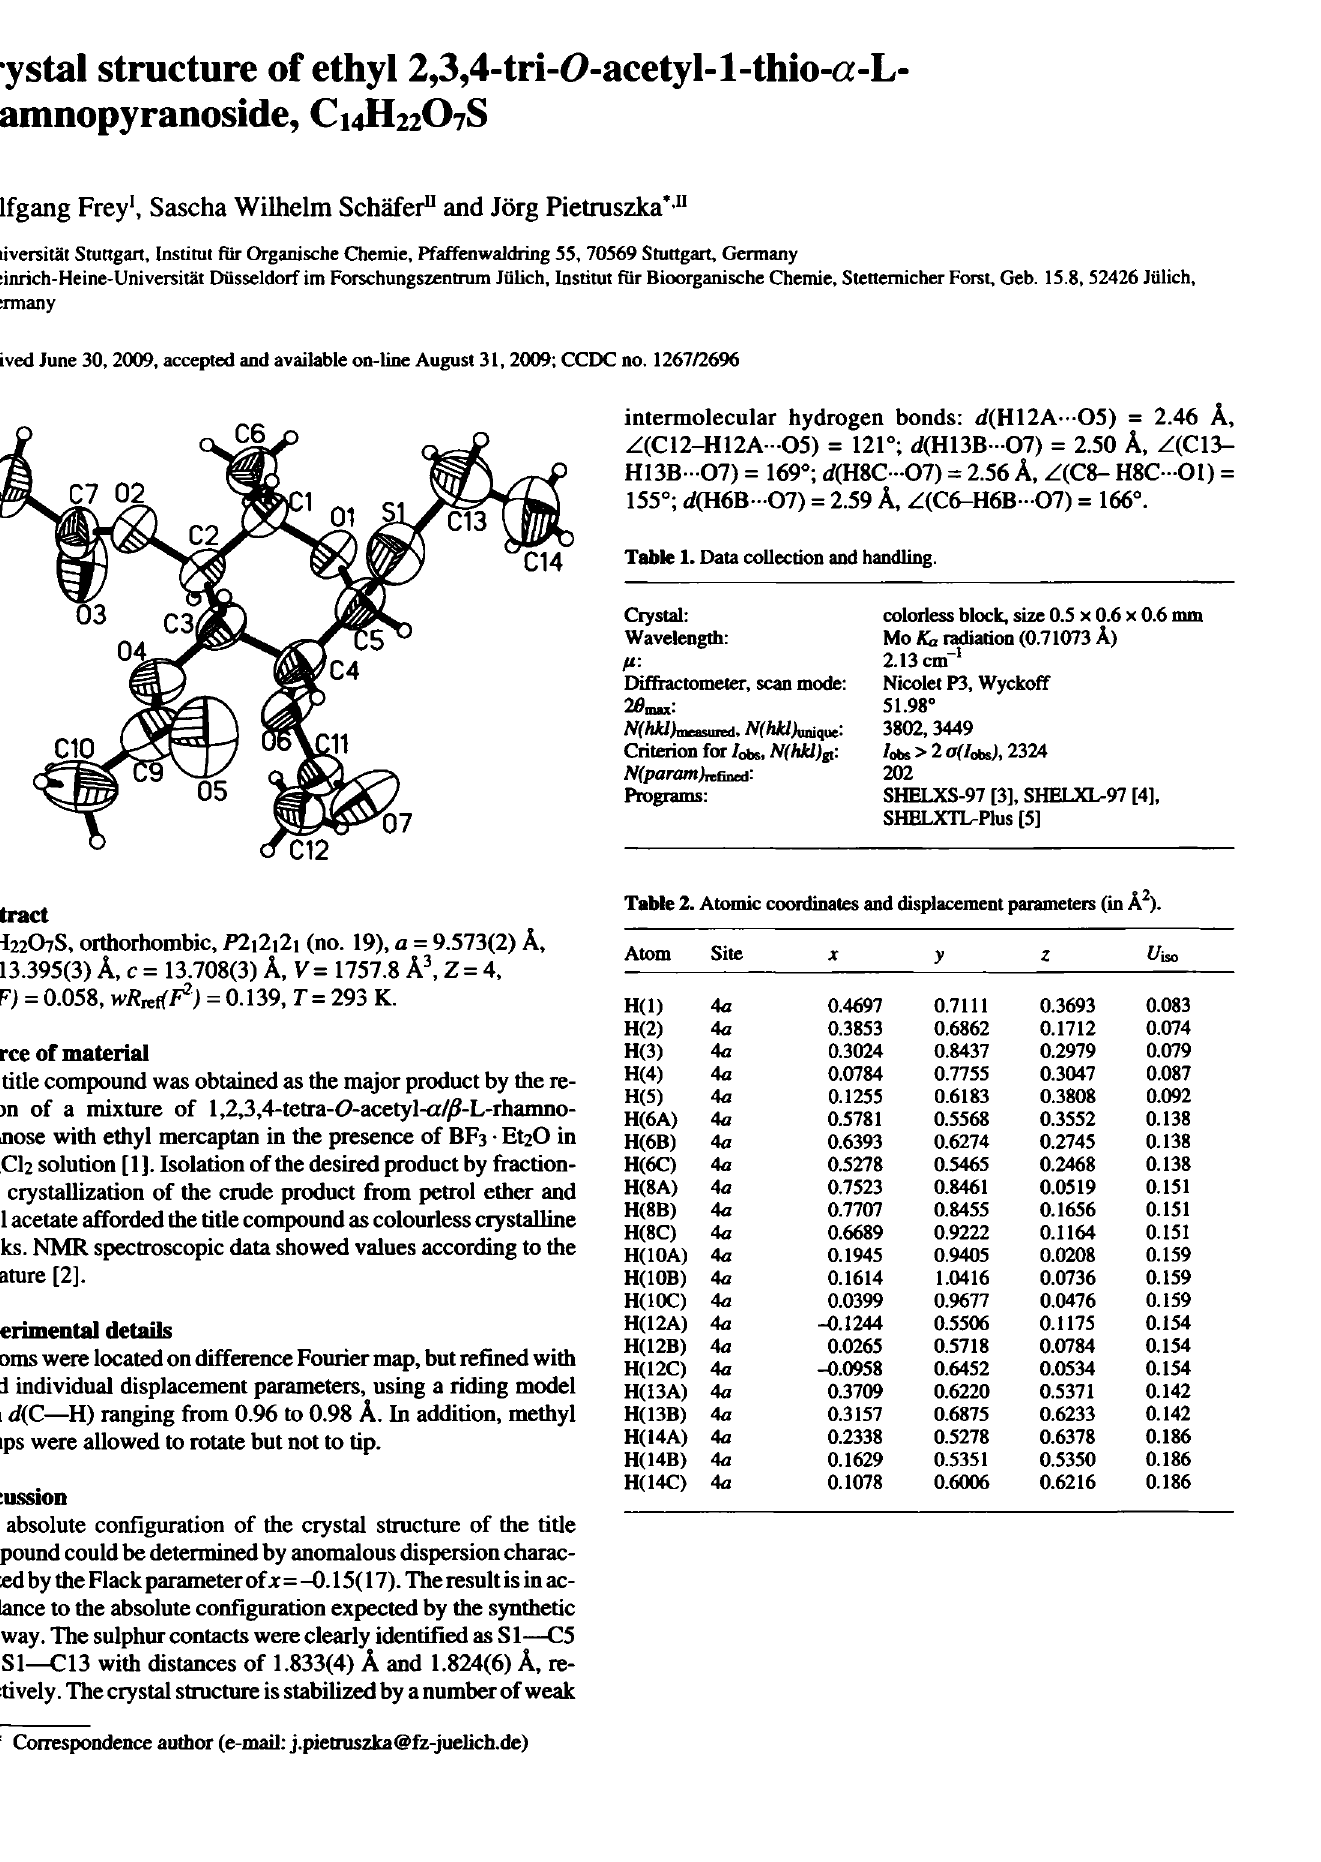
Table 1. Data collection and handling.